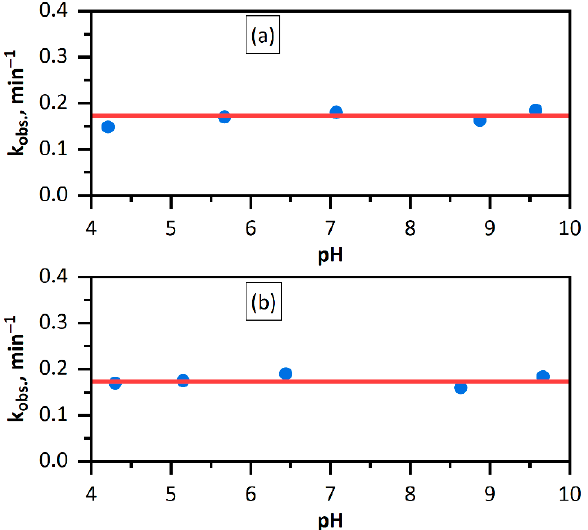
Figure 3. Observed rate constants of the reduction of Fe(CN) 63 – ions with hydrogen vs. pH of the solution in non-stirring ( a ) and stirring ( b ) regimes. Solution: [ Fe(CN) 63 – ] = 1.00 mM, [ Pd 0 ] = 0.020 mM, [H 2 ] = 0.80 mM (p(H 2 ) = 1.025 atm).